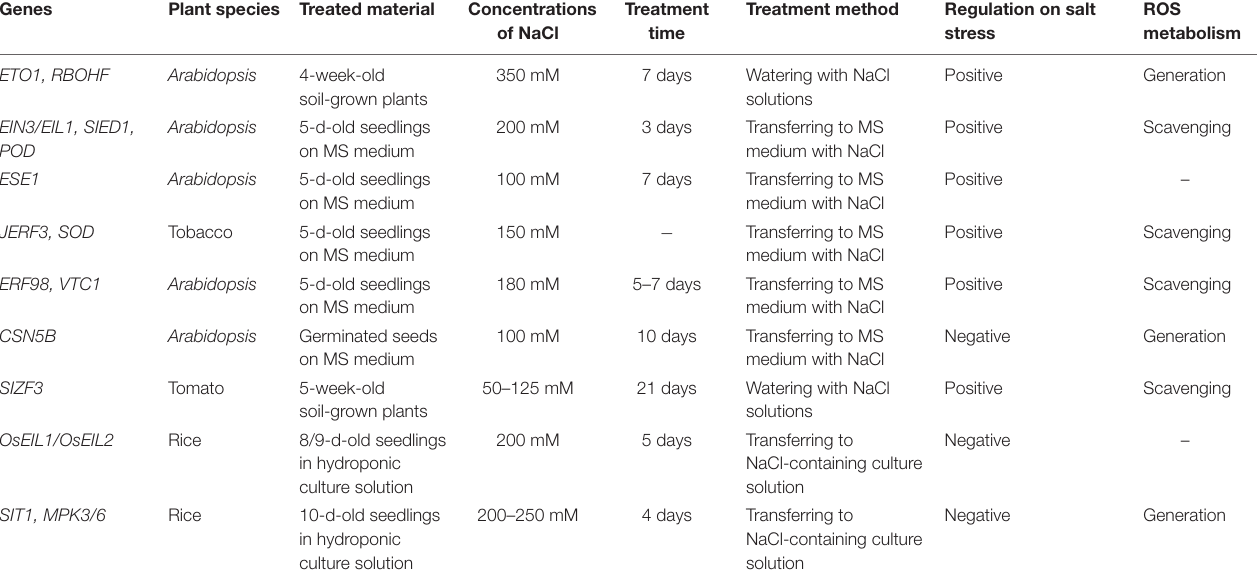
TABLE 1 | Genes involved in ethylene- and AsA-mediated ROS homeostasis in response to salt stress. Genes Plant species Treated